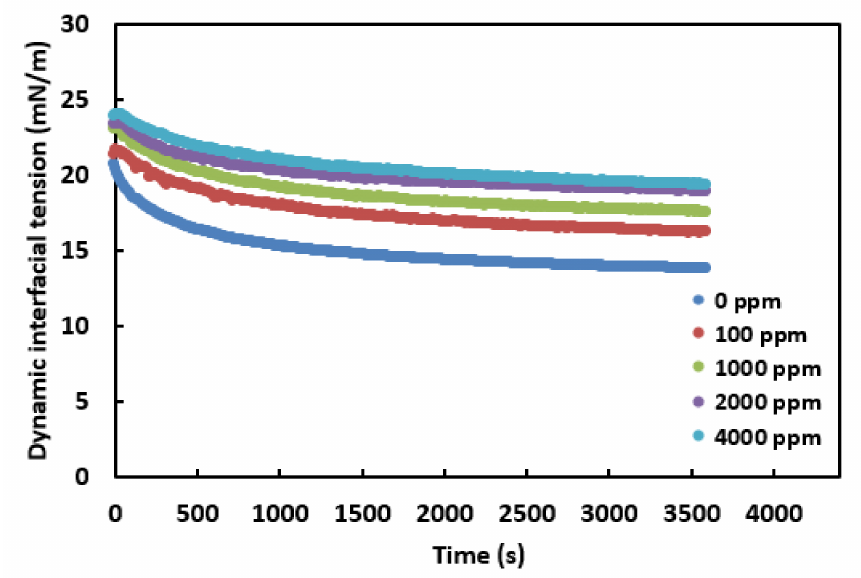
Figure 6. Dynamic crude oil-water interfacial tensions in the presence of Span 80 at different nanoparticle